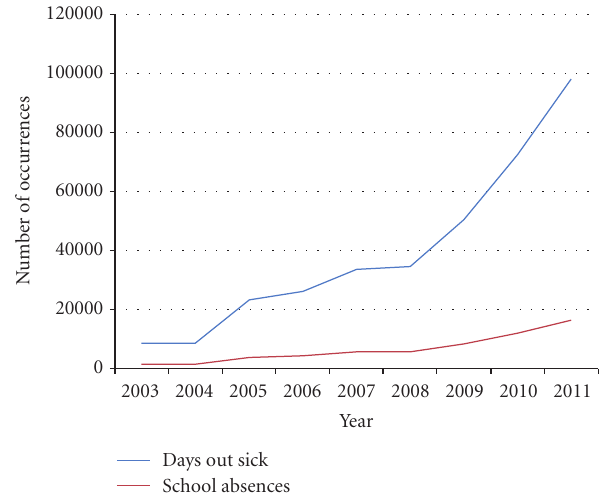
F 6: Additional impacts of emissions reduction.